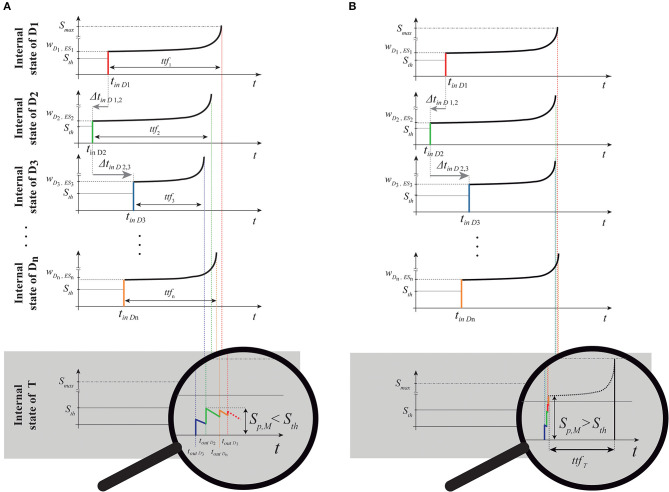
Representation of the same spike train shown in Figures 2, 3 passing through the delay layer and related impact on the internal state of the delay neurons Di and target neuron T. (A) Internal neuron representation (SDi) of the absolute spike times (tinD1, tinD2,., tinDn) and relative intervals (ΔtinD1,2, ΔtinD2,3, ..., ΔtinDn−1,n) of the parallel spike train. In this case, the target will not produce a spike because the simultaneity condition at the target is not reached (relative intervals of the input are not coincident with the PPT of the structure); (B) we show the response of a structure with a different PPT, to the same parallel input train, which summation tends to the simultaneity condition. Consequently, such pattern is detected, and then the spike is generated. It happens after a proper time-to-fire ttfT. To show the summation process to the reader, the diagram of the internal state of the target neuron is zoomed for ease of illustration. Note that the temporal values in this internal representation are symmetrical with respect to Figures 2, 3 since we are representing here the Cartesian temporal axis of times and not a “photography” of the parallel spike train entering the structure.